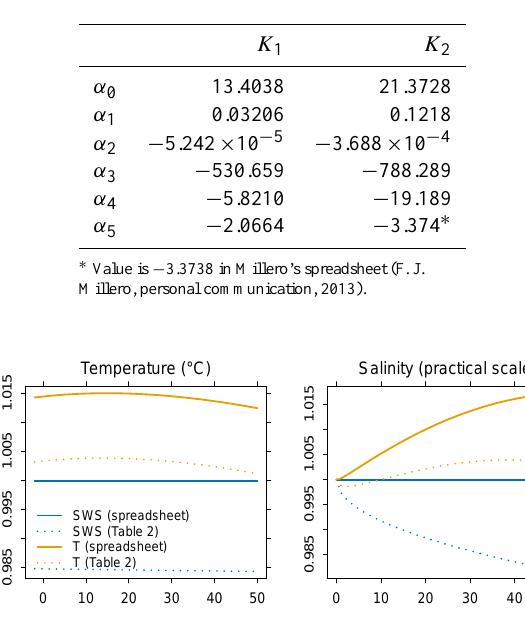
Figure 16. The ratio of K 1 /K 2 for each set of coefficients from Millero (2010) over the same ratio for the reference. We refer to that ratio of ratios as the K 1 /K 2 quotient. The reference is chosen arbitrarily as Millero’s set of coefficients on SWS scale from his spreadsheet. Curve colors and line patterns are as in Fig.